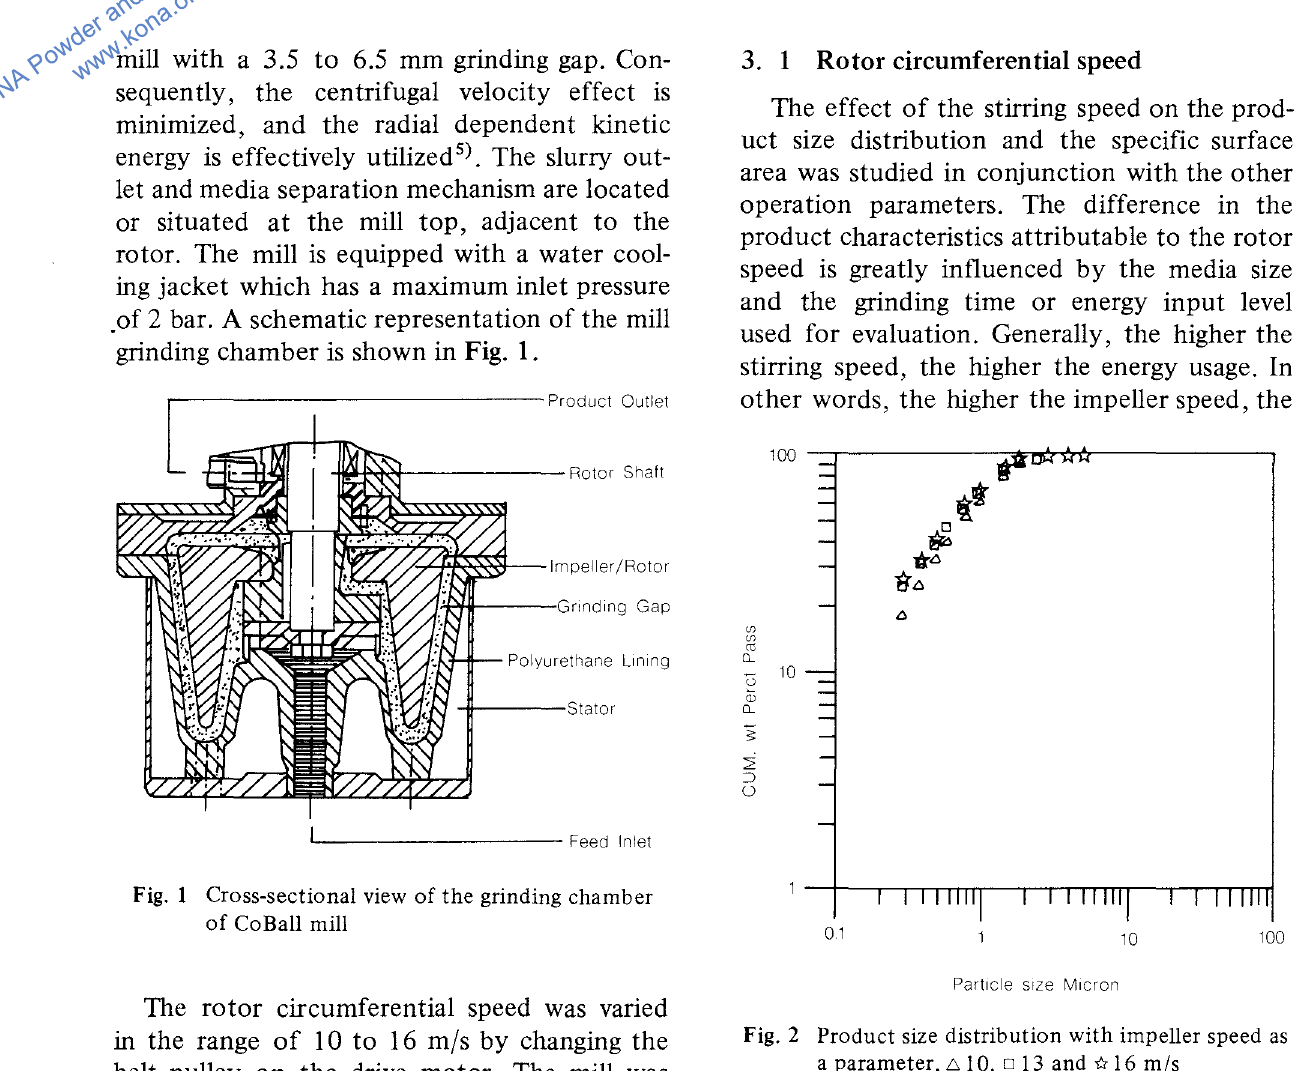
Fig. 2 Product size distribution with impeller speed as a parameter, tc.l 0, o 13 and -ti 16 mjs finer the product size as depicted in Fig.